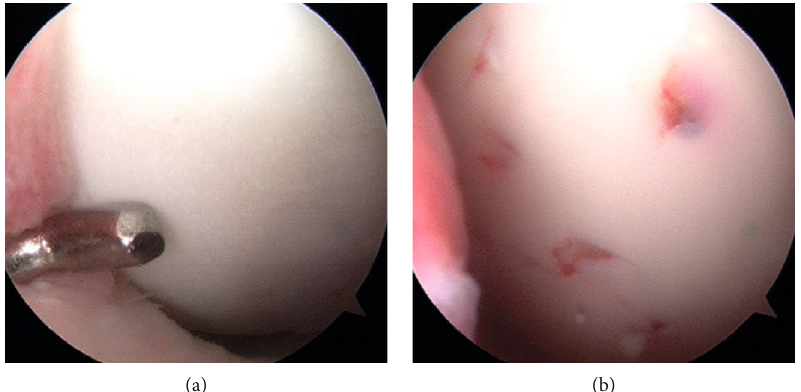
Figure 3: Arthroscopic fi nding of the left medial femoral condyle. (a) The lesion was identi fi ed by probing the cartilage surface and cleavage in the rim was detected. (b) Percutaneous drilling was performed in the lesion.